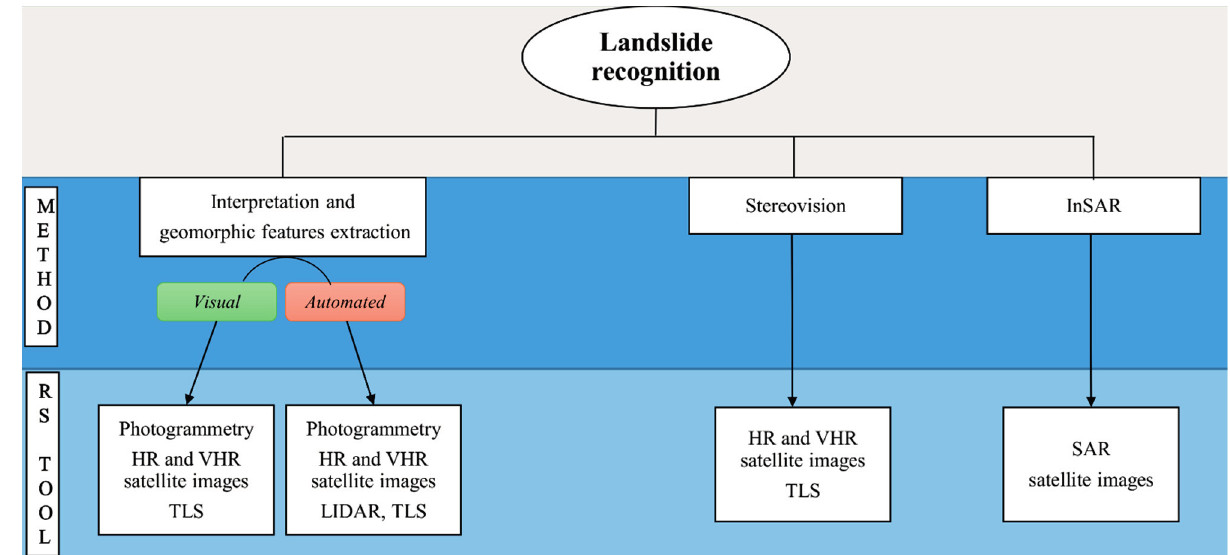
Figure 1. Overview of Remote Sensing techniques applied to landslide recognition.